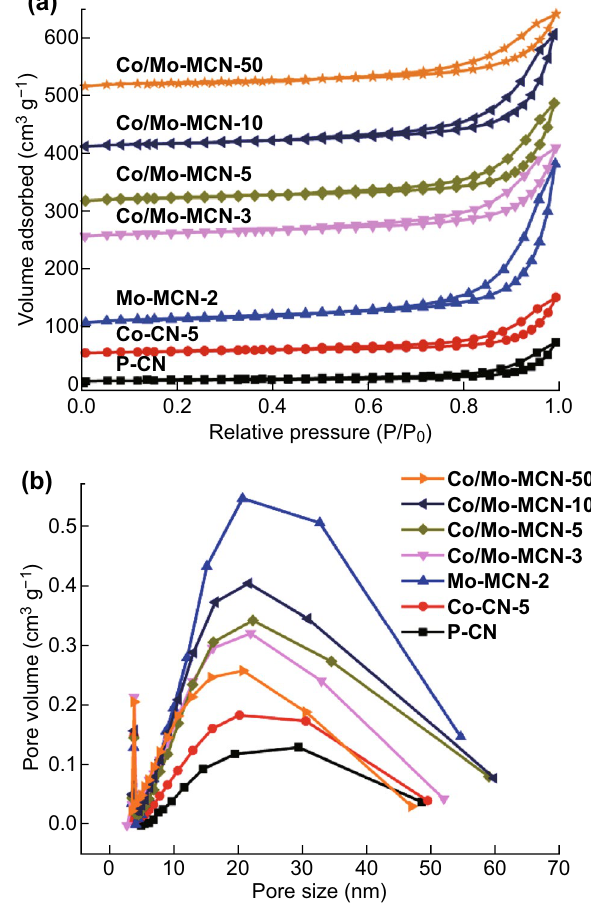
Fig. 2 a Nitrogen adsorption–desorption isotherms and b cor- responding pore size distribution curves of P-CN, Co-CN-5,